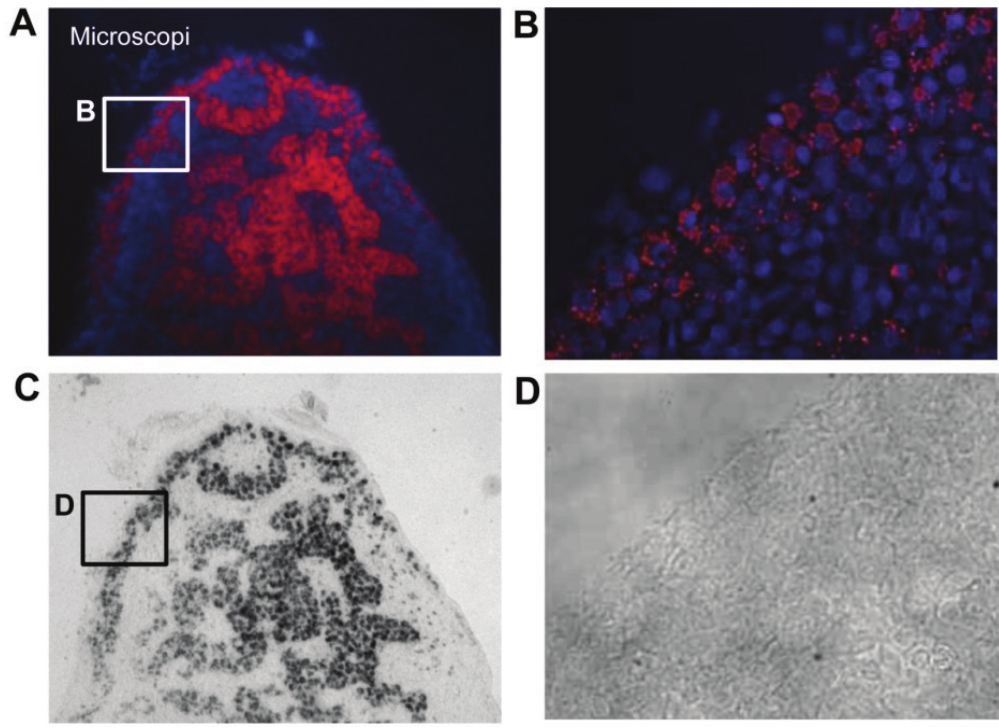
Figure 7. Microscopy images of a cryosectioned SLN. ( a ) Coronal section (20 μm) of a half SLN indicating the microdistribution of the nanoparticles within the SLN. The blue structures are cell nucleus and the red light is emitted from the 99m Tc-AF-SPIONs. The nanoparticles accumulate in the cortex and within the medullary sinuses. ( b ) Image visualizing the cortex of the SLN and indicating that the nanoparticles are mostly located extracellularly in comparison with the medullary sinus where the nanoparticles seem to be located within the macrophages. ( c ) and ( d ) bright field images of the SLN corresponding to ( a ) respectively ( b ) which show the orientation and